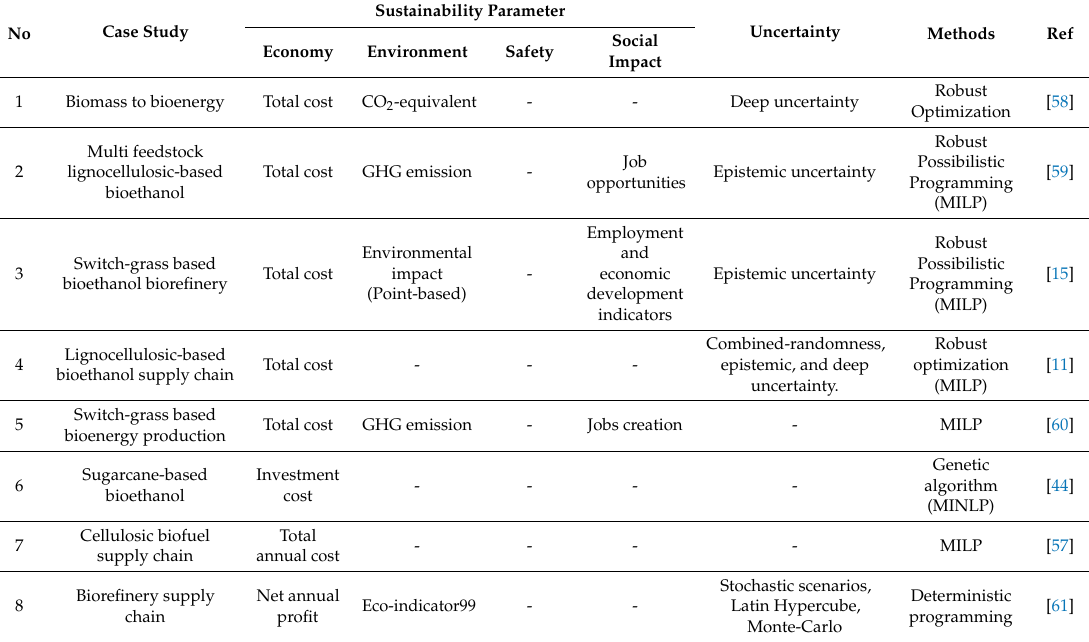
Table 1. Summary of Biorefinery Process Optimization Case